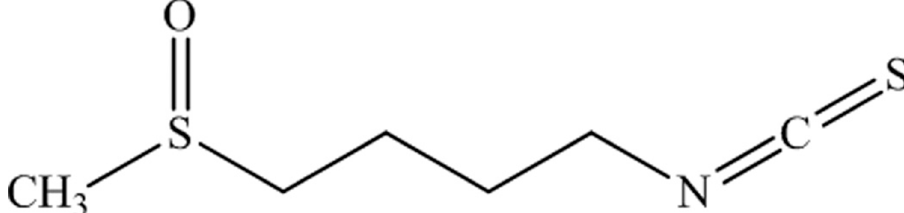
Figure 3. Chemical structure of the sulforaphane compound showing the nature of sulfur. Modified from [117].